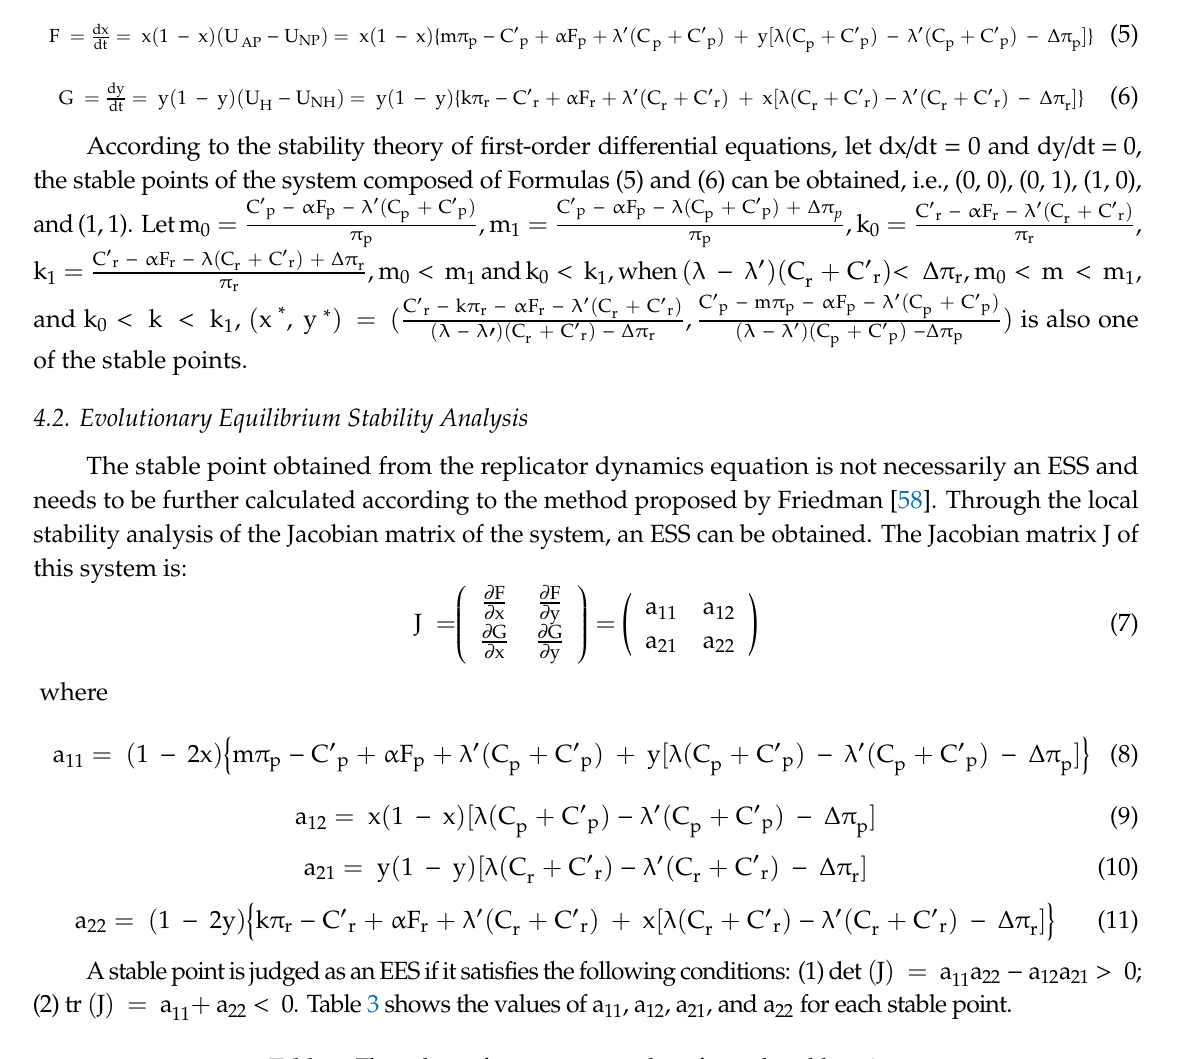
Table 3. The values of a 11 , a 12 , a 21 , and a 22 for each stable